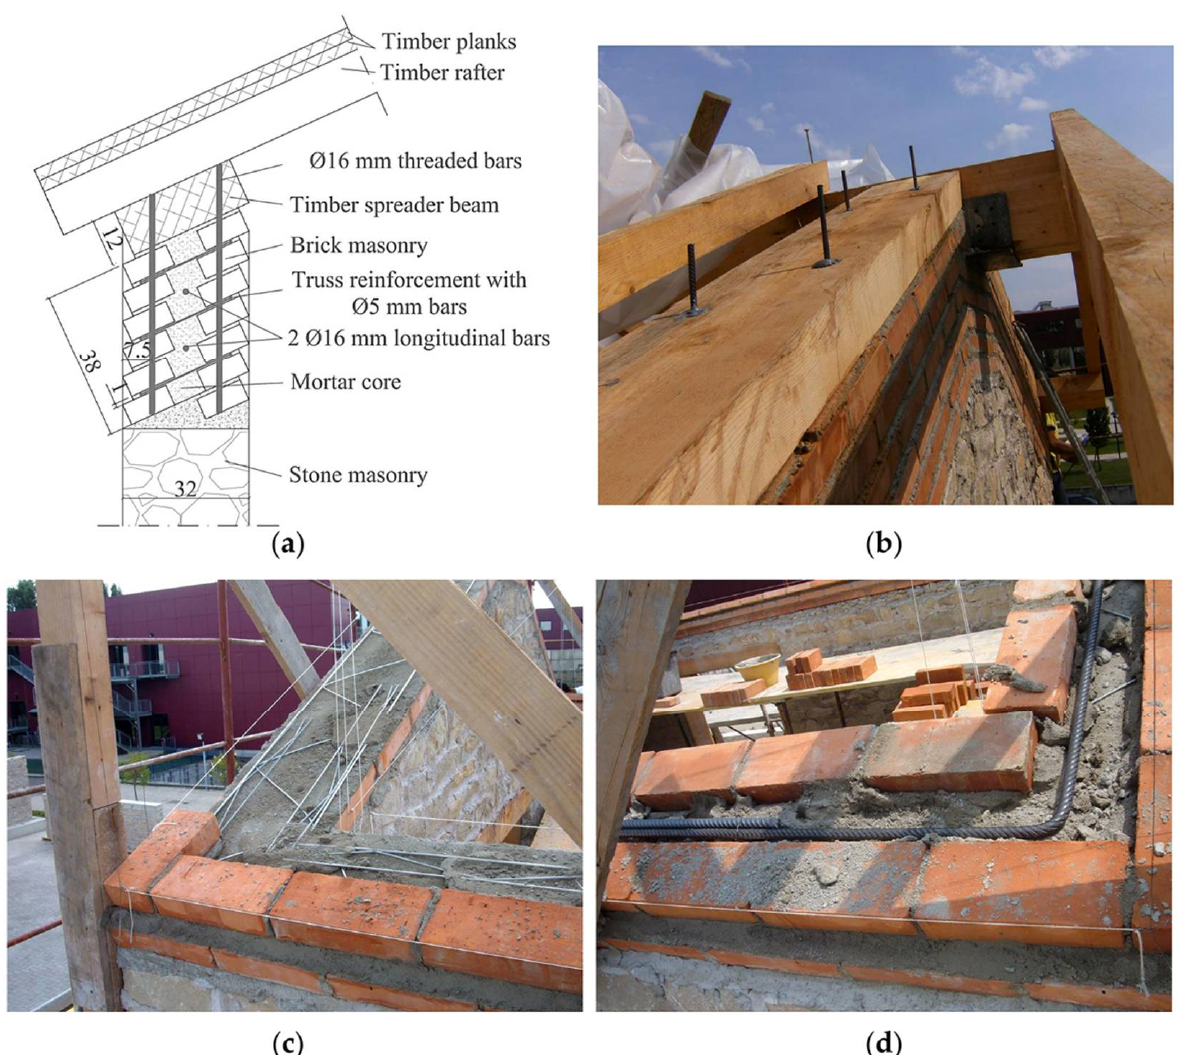
Figure 8. Building 2, retrofit at the roof level: ( a ) structural detail of the RM ring beam; ( b ) timber spreader and ridge beams connected to the RM ring beam above a gable; ( c ) horizontal truss reinforcement at corner; ( d ) longitudinal reinforcing bars at corner. Units of cm.